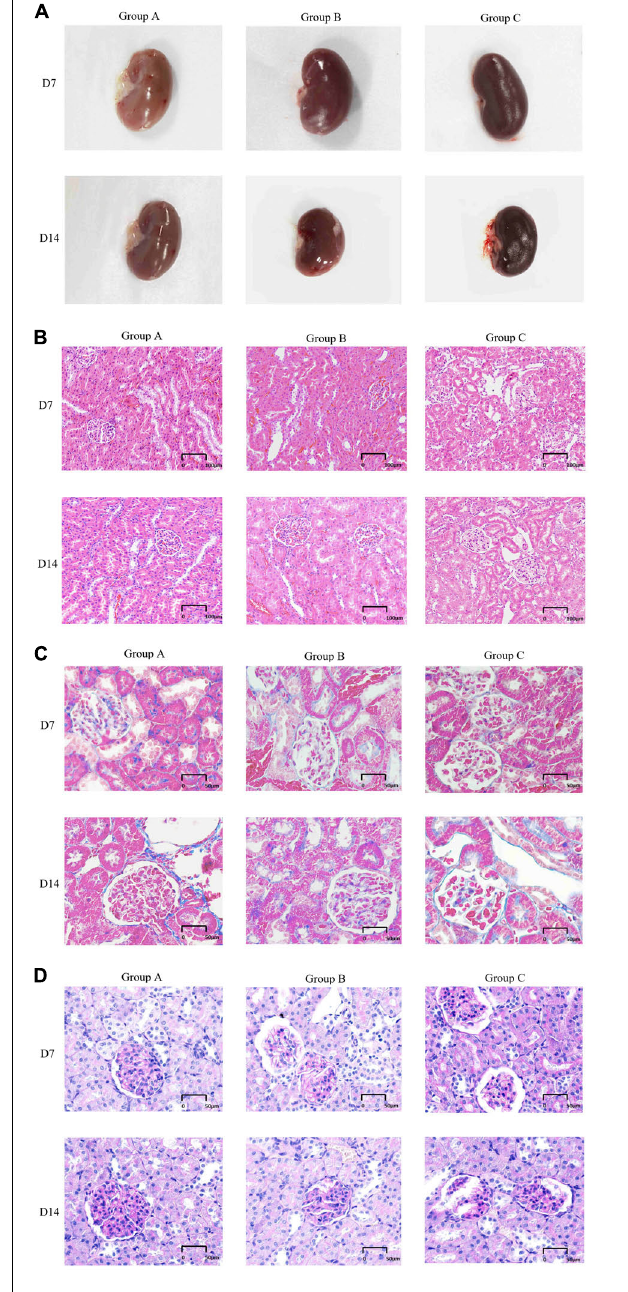
FIGURE 4 | General features and morphological traits in renal tissues obtained from animals subjected to normoxic and hypoxic conditions. (A) Gross view of a kidney. (B) A histological section of kidney tissue. The histological examination was performed at 20 × magnification (scale bar = 100 µ m). (C) Periodic acid-Schiff staining (40 × magnification, scale bar = 50 µ m). (D) Masson’s trichrome staining (40 × magnification, scale bar = 50 µ